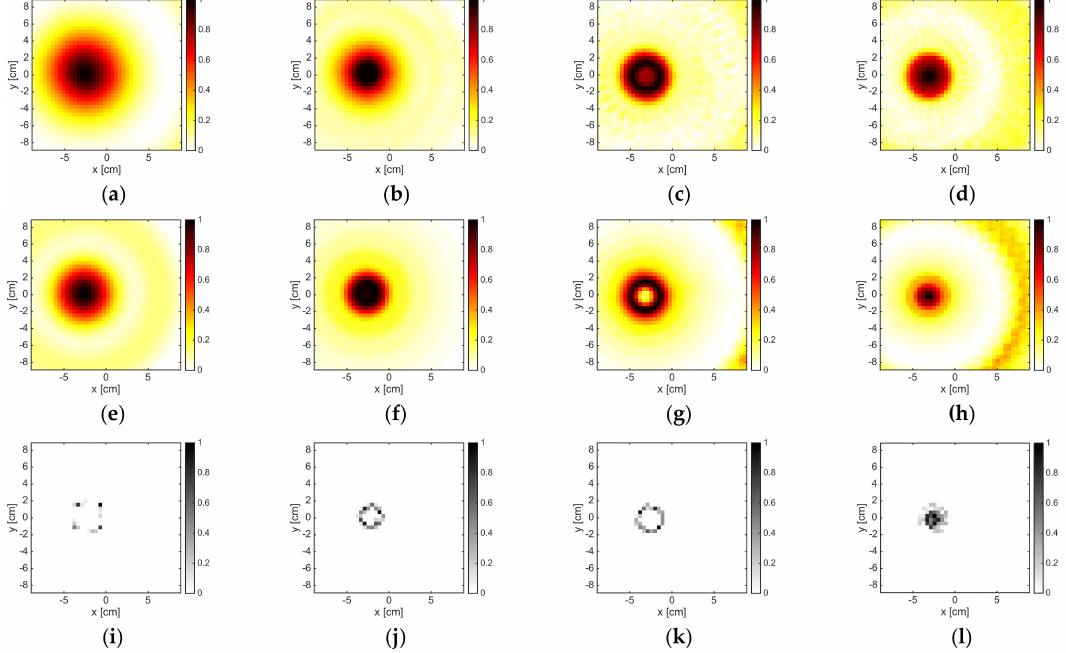
Figure 2. The DielTM target. From left to right: 2 GHz, 6 GHz, 12 GHz, and 16 GHz. From top to bottom: LSM, OSM, and B-IS indicators. The number of measurements and views was M = 36.